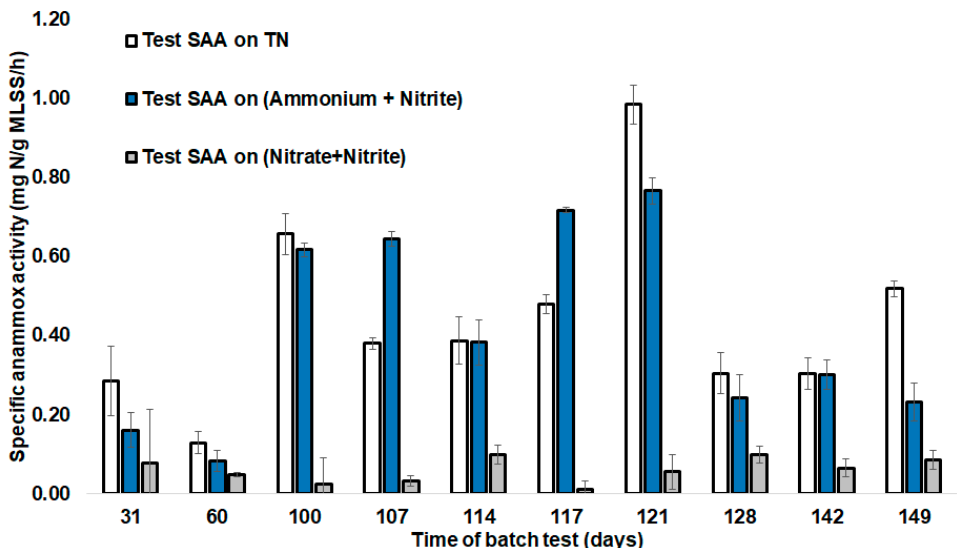
Figure 3. SAAs during batch testing in SBR operation days. Error bars represent the standard deviation between parallel batch tests (n = 3).